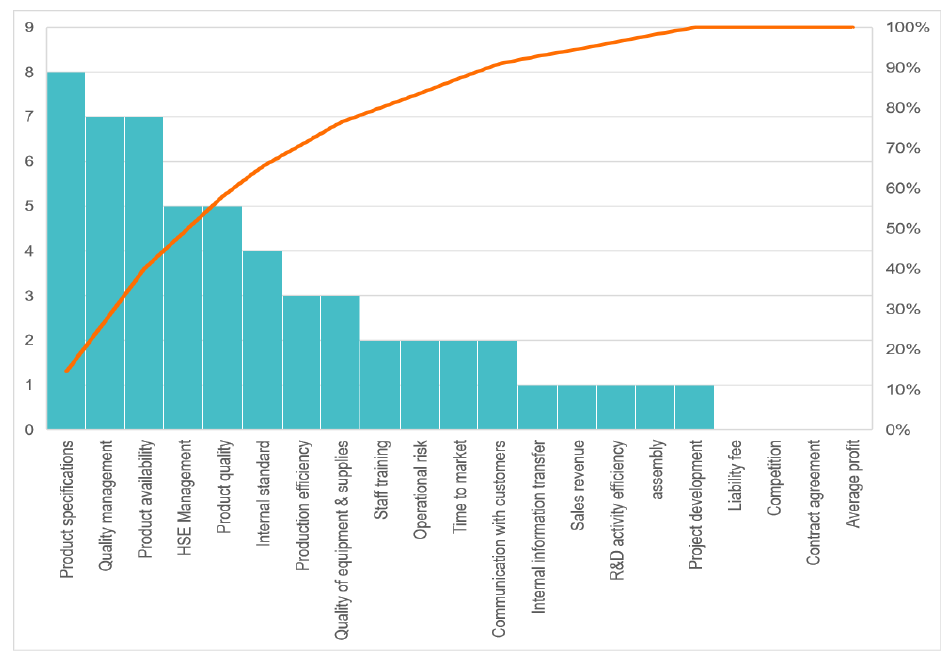
Figure 7. Pareto diagram of standard’s most significant impacts.